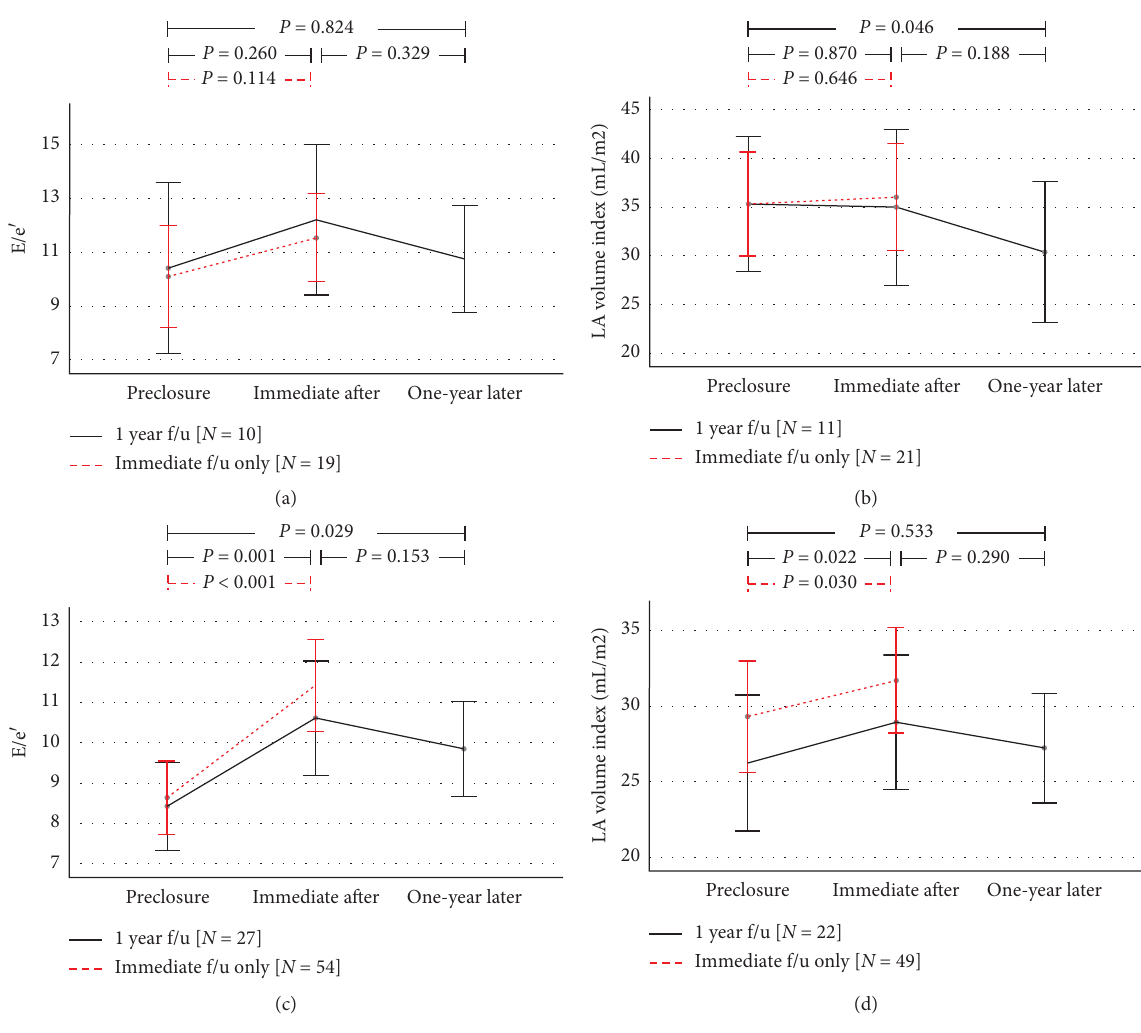
Figure 4: Serial changes in E/e’, left atrial (LA) volume index, tricuspid regurgitant (TR) velocity, and left ventricular (LV) stroke volume from preclosure stage to one-year follow-up in (a, b) immediately increased PASP group and (c, d) immediately decreased PASP group. Blue dotted line represents comparisons between preclosure state and immediately after (one-day after closure) follow-up only. Bars represent 95% confidence